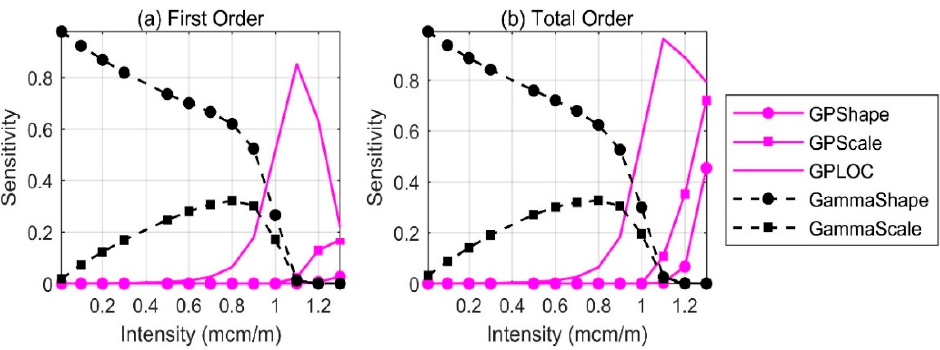
Figure 2. ( a ) The first order and ( b ) the total order sensitivity indices of Mixture Gamma-GPD model for drought return period. for drought return